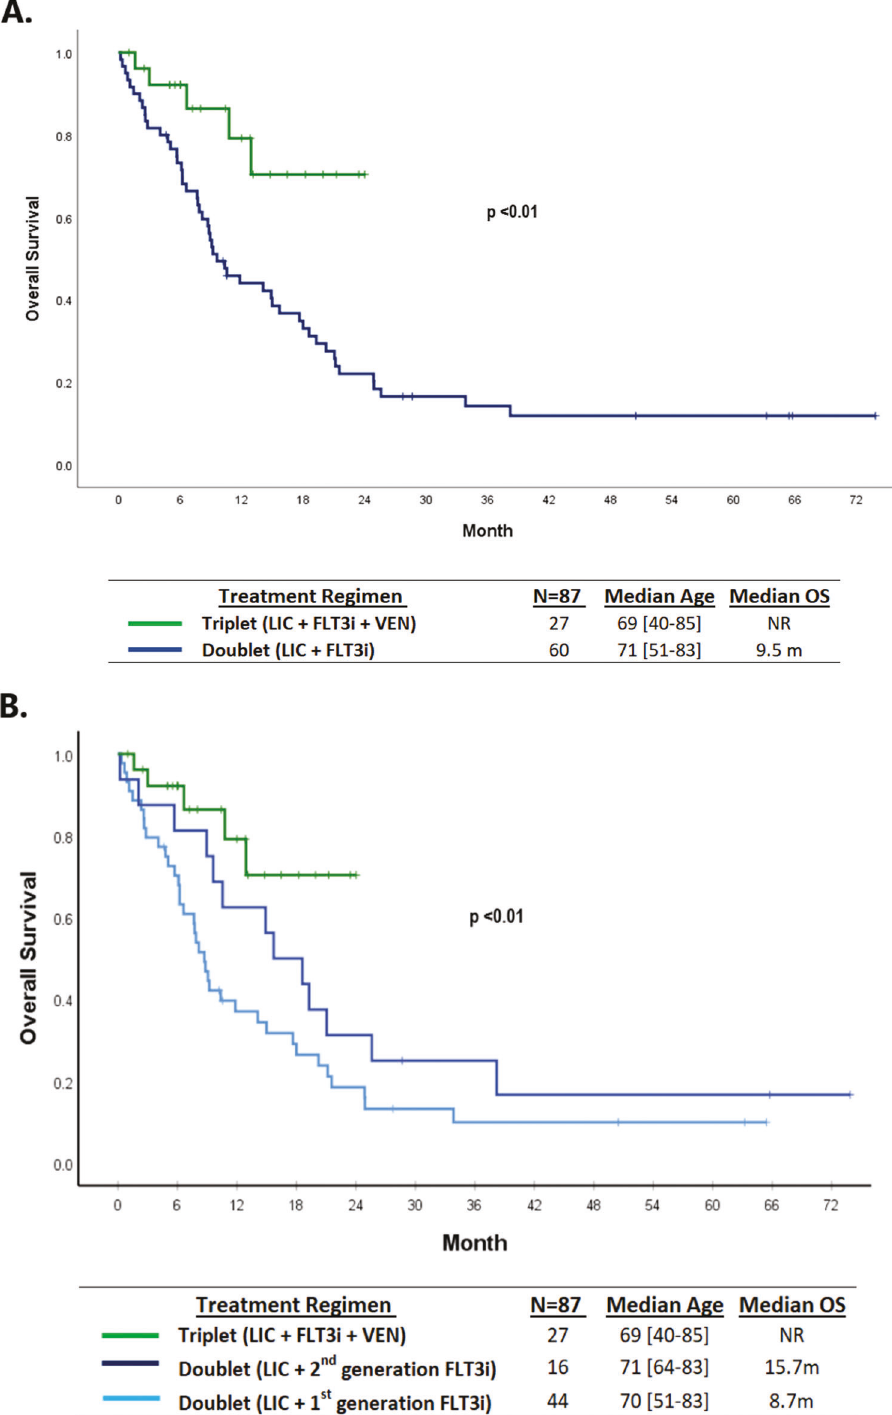
Fig. 4 Overall survival in patients treated with doublets vs. triplets ( A ) and triplets vs. 1 st generation FLT3i-based doublets vs. 2 nd generation FLT3i-based doublets ( B ). A The median follow-up time was shorter in the triplet arm than in the doublet arm, 12 versus 63 months ( p < 0.01), re fl ecting the more recent use of triplet regimens at our institution (mostly mid-2018 onwards). Patients treated with a triplet regimen (green) achieved longer median OS compared with patients treated with a doublet regimen (dark blue) (NR versus 9.5 months, P < 0.01). B The median OS in patients treated in the three groups: Triplets (green), doublets with second-generation (quizartinib or gilteritinib) FLT3 inhibitors (dark blue), and doublets with fi rst-generation (midostaurin or sorafenib) FLT3 inhibitors (light blue) were NR, 15.7 months, and 8.7 months, respectively ( P < 0.01). There was no statistically signi fi cant OS difference between patients treated with fi rst- vs. second- generation FLT3i-based doublets ( P = 0.19). LIC low intensity chemotherapy, FLT3i FLT3 inhibitor, VEN venetoclax, OS overall survival, m month, NR not